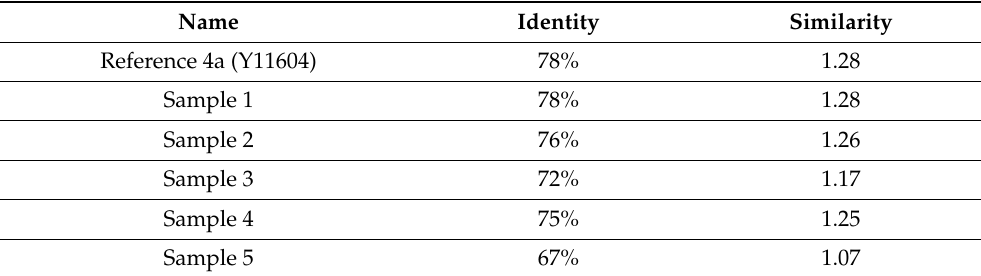
Figure 3. Ramachandran plot of the 3D models of HCV NS5B genotype 4a-resistant samples and reference exceeding 91.4% of the residues in the favored regions and around 5% of residues in the allowed regions. F791 (reference), f793 (sample 1), f803 (sample 2), f804 (sample 3), f805 (sample 4), and f806 (sample 5). Table 4. Sequence identity and similarity between the template and five resistant